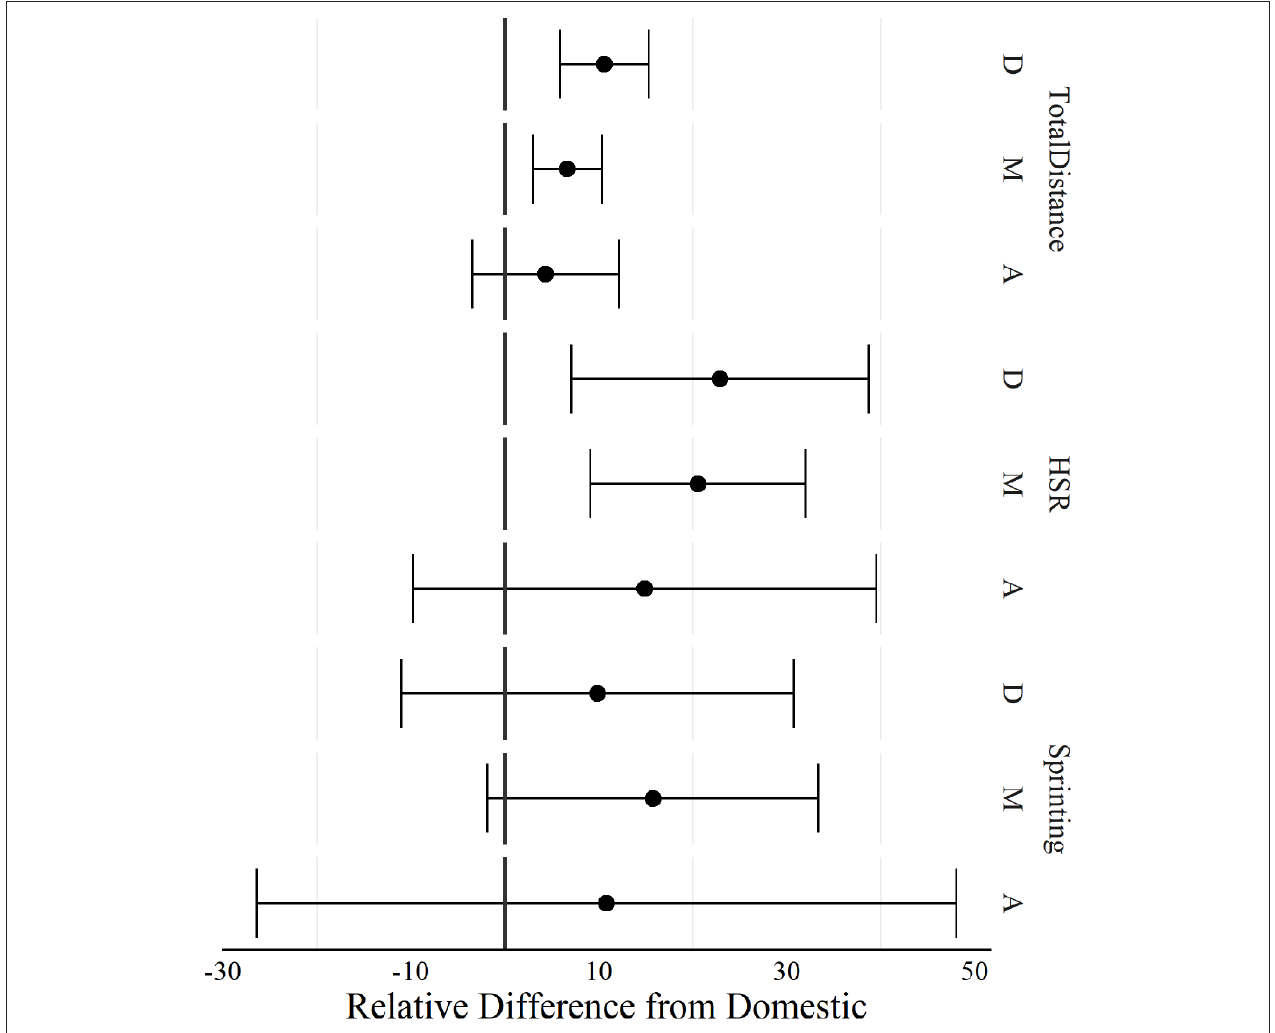
FIGURE 1 | Positional comparison of total distance, high-speed running, and sprinting between players competing in domestic and international women’s football matches. HSR, High-speed running (16–20 km · h − 1 ); sprinting ( > 20 km · h − 1 ); D, Defenders; M, Midfielders; A, Attackers. A negative difference indicated, domestic was greater than international, a positive difference indicated international was greater than